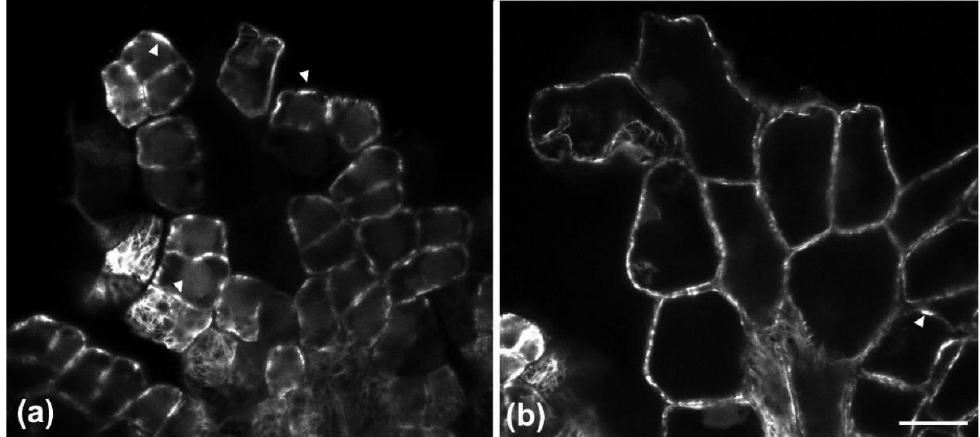
Figure 6. Single CLSM sections depicting microtubule organization in early developing cells of the external epidermal ( a ) and hypodermal ( b ) adaxial layers, at the same leaf area, after tubulin immunostaining. Microtubule bundles are already organized in external epidermal cells (arrowheads in a ), while microtubule bundle initiation is just beginning in some cells of the hypodermis (arrowhead in b ). Scale bar: 20 µ